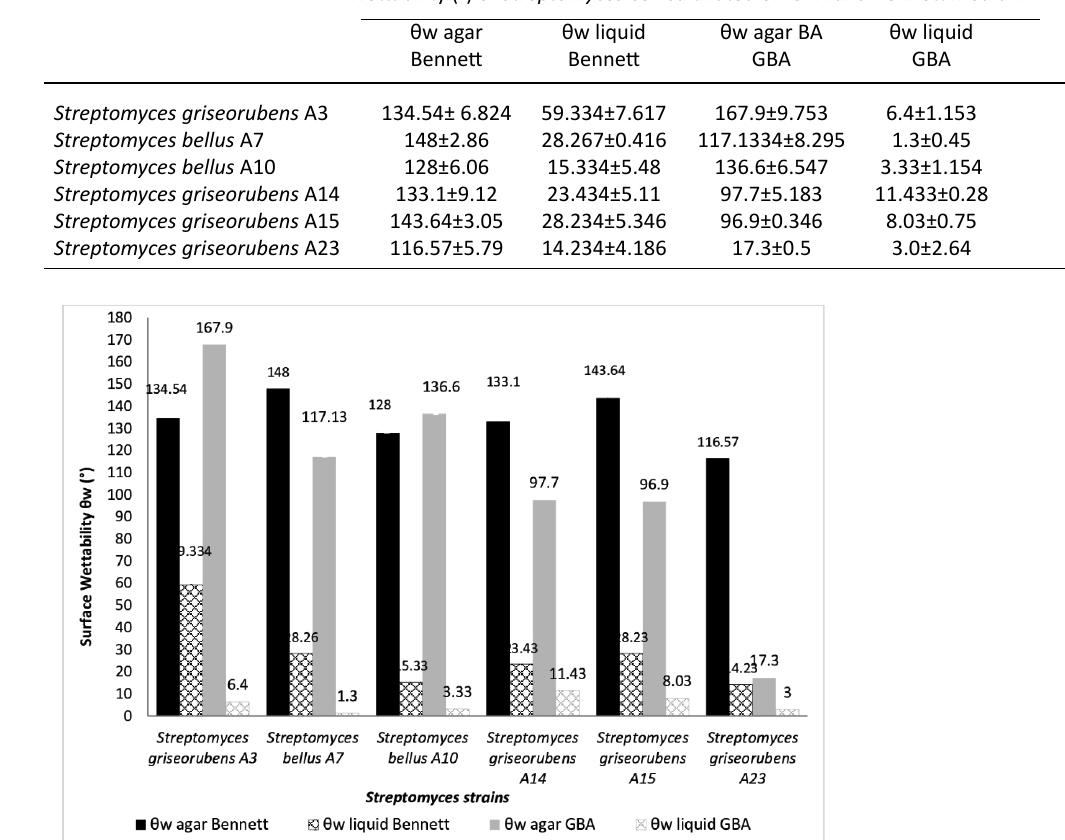
Fig. 1. Surface wettability (θw) of Six Streptomyces strains cultivated on Bennett liquid, agar Bennett, GBA liquid and agar GBA